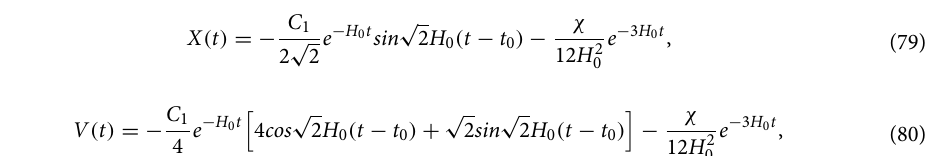
0 , χ 1 and C 1 ρ 0 = = =